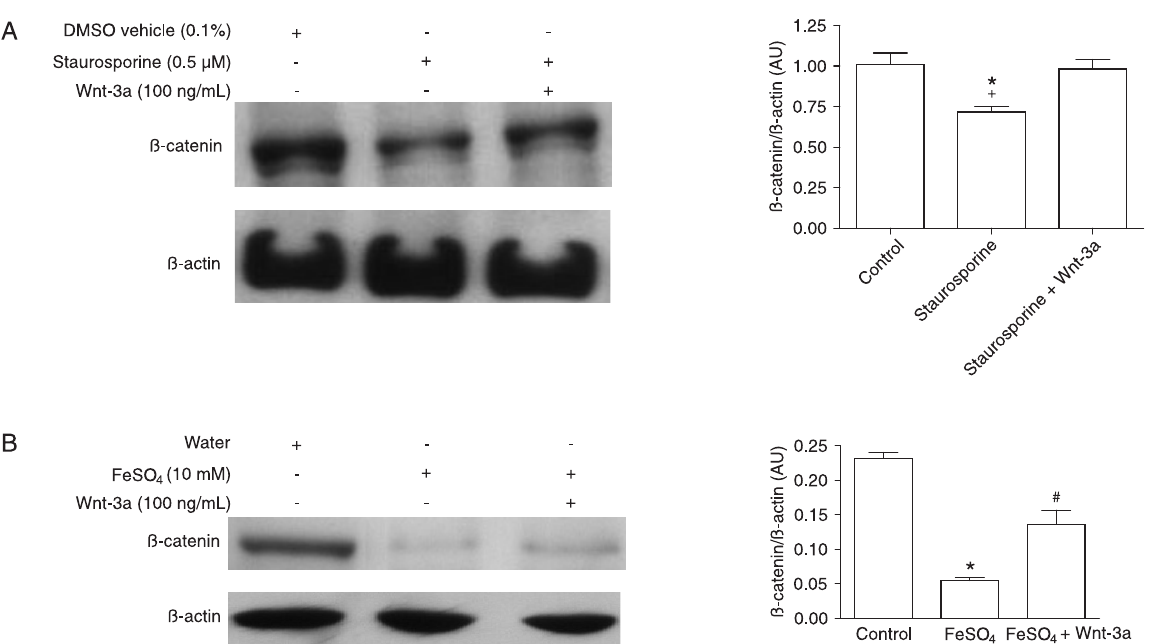
Figure 8. Effect of recombinant Wnt-3a protein on β-catenin protein suppression induced by staurosporine and FeSO 4 . PC12 cells were pre-incubated with Wnt-3a recombinant protein (100 ng/mL) 24 h before treatment with 500 nM staurosporine and 10 mM FeSO 4 . Twenty-four hours later, cytosolic proteins (10 µg) were isolated and β-catenin levels were determined by immunoblot. The respective densitometric analyses (arbitrary units, AU) of the β-catenin/β-actin ratio bands are presented in Panels A and B . Data are reported as means ± SEM for 3 independent experiments (one-way ANOVA followed by the Newman-Keuls test). *P < 0.05 vs control; + P < 0.01 vs staurosporine + Wnt-3a; # P < 0.05 vs control and FeSO 4 . β-actin was used as internal